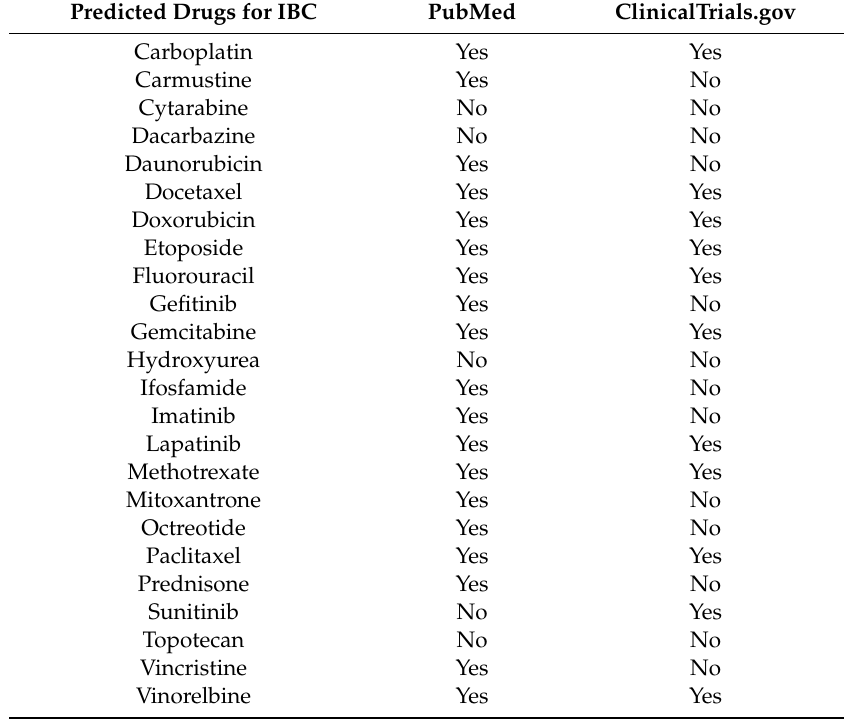
Table 3. Evaluation of predicted IBC drugs in PubMed or ClinicalTrials.gov. Predicted Drugs for IBC